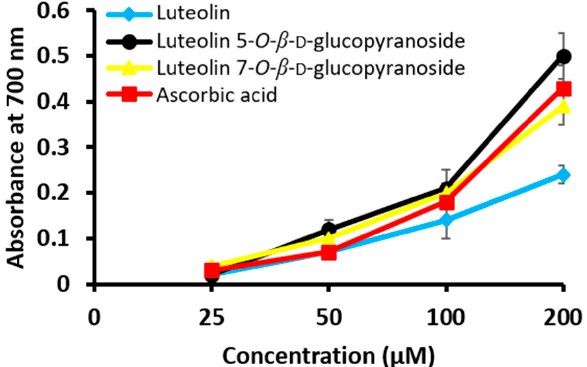
Figure 3. Pro-oxidant activity of different isolated compounds from C. maackii as measured from Fenton reaction using ascorbic acid as positive control. Data are represented as mean ± SD of triplicate experiments.